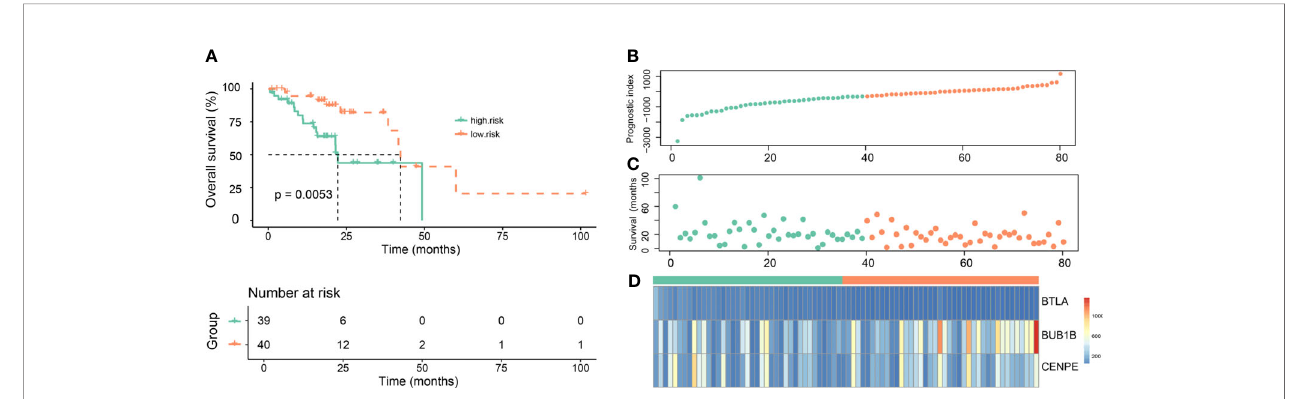
FIGURE 4 | Evaluation of the prognostic value of the gene signature in the Genomic Data Commons dataset from the Cancer Genome Atlas. (A) Kaplan – Meier survival curves for overall survival (OS) in the high-risk and low-risk groups. (B) The risk score distribution. (C) Distribution of patient survival time. (D) Heat map of three gene expressions (BTLA, BUB1B, and